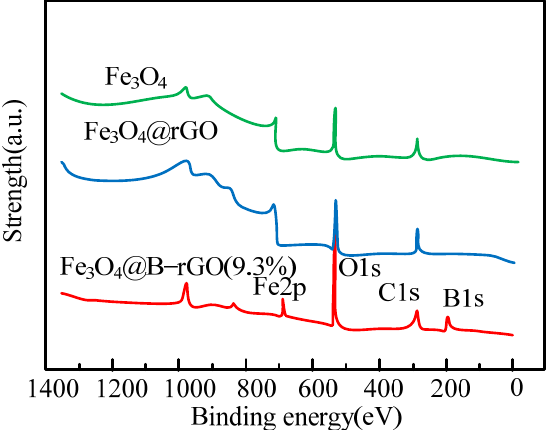
Figure 5. Full XPS spectra of Fe 3 O 4 @B-rGO (9.3%), Fe 3 O 4 @rGO and Fe 3 O 4 .